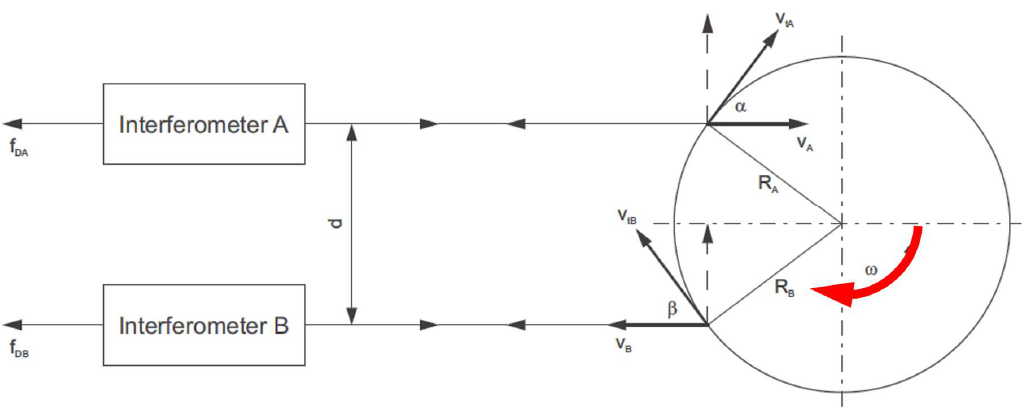
Figure 8. Schematic diagram illustrating the operating principle of a laser angular velocity relay.